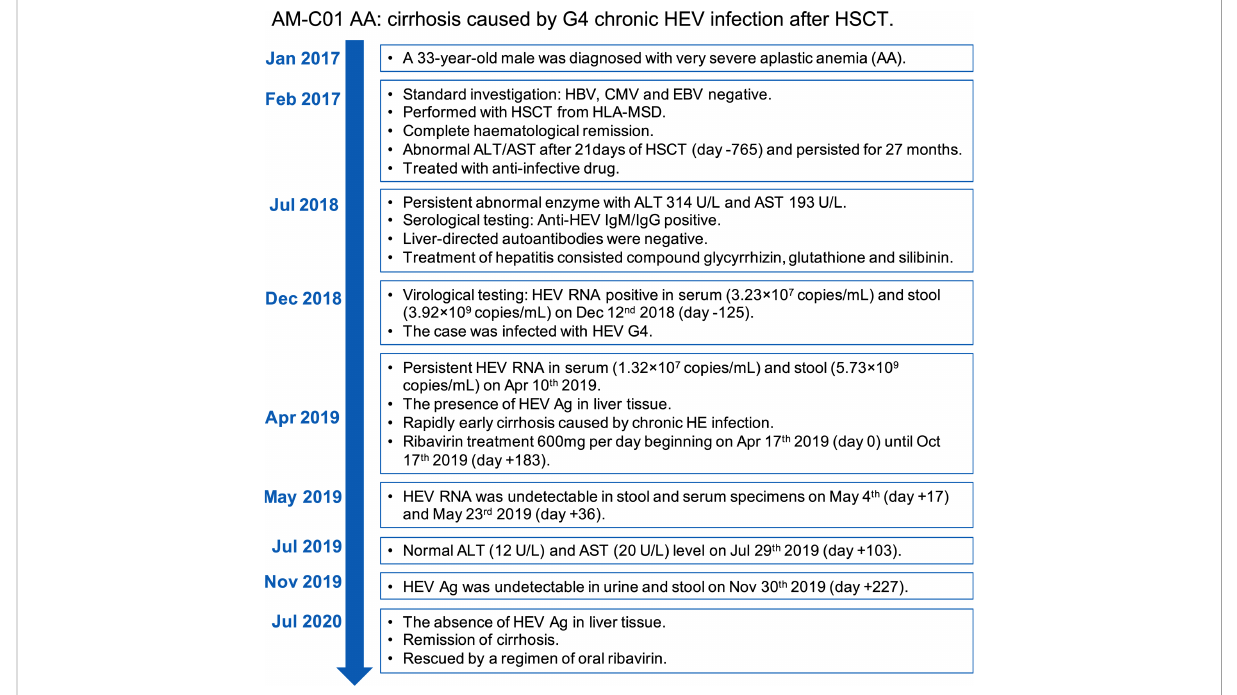
FIGURE 4 Overview of the case ’ s diagnosis, management, and follow-up process and timelines of major clinical